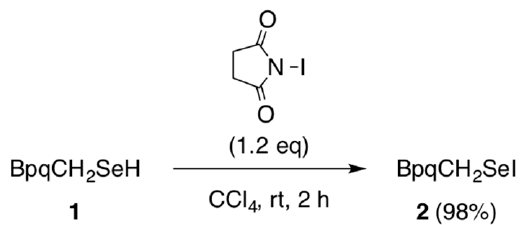
Scheme 2. Synthesis of the primary-alkyl-substituted selenenyl iodide 2 .